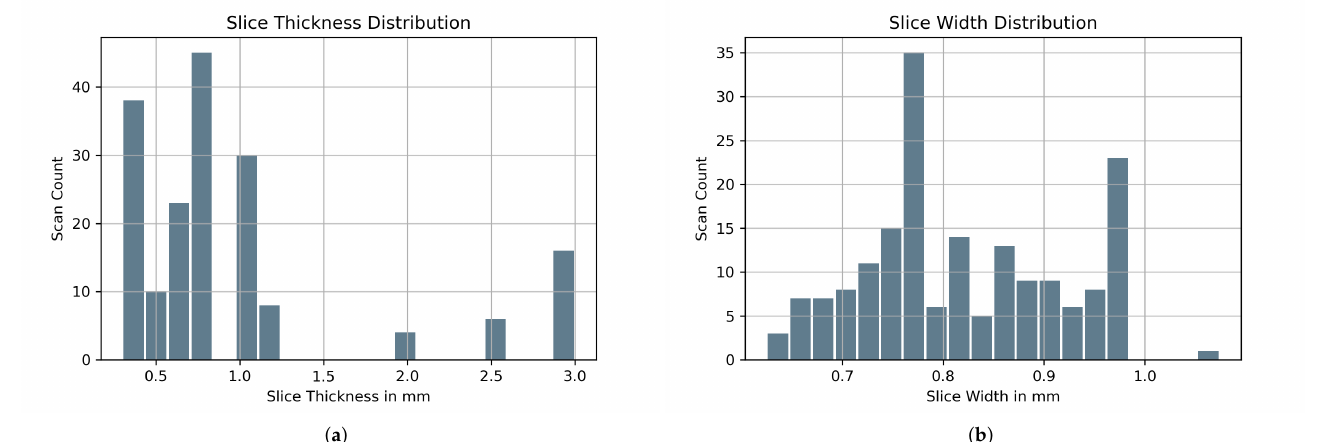
Figure 2. Spatial resolution of 180 CT scans used in the research where ( a ) Slice Thickness and ( b ) Slice